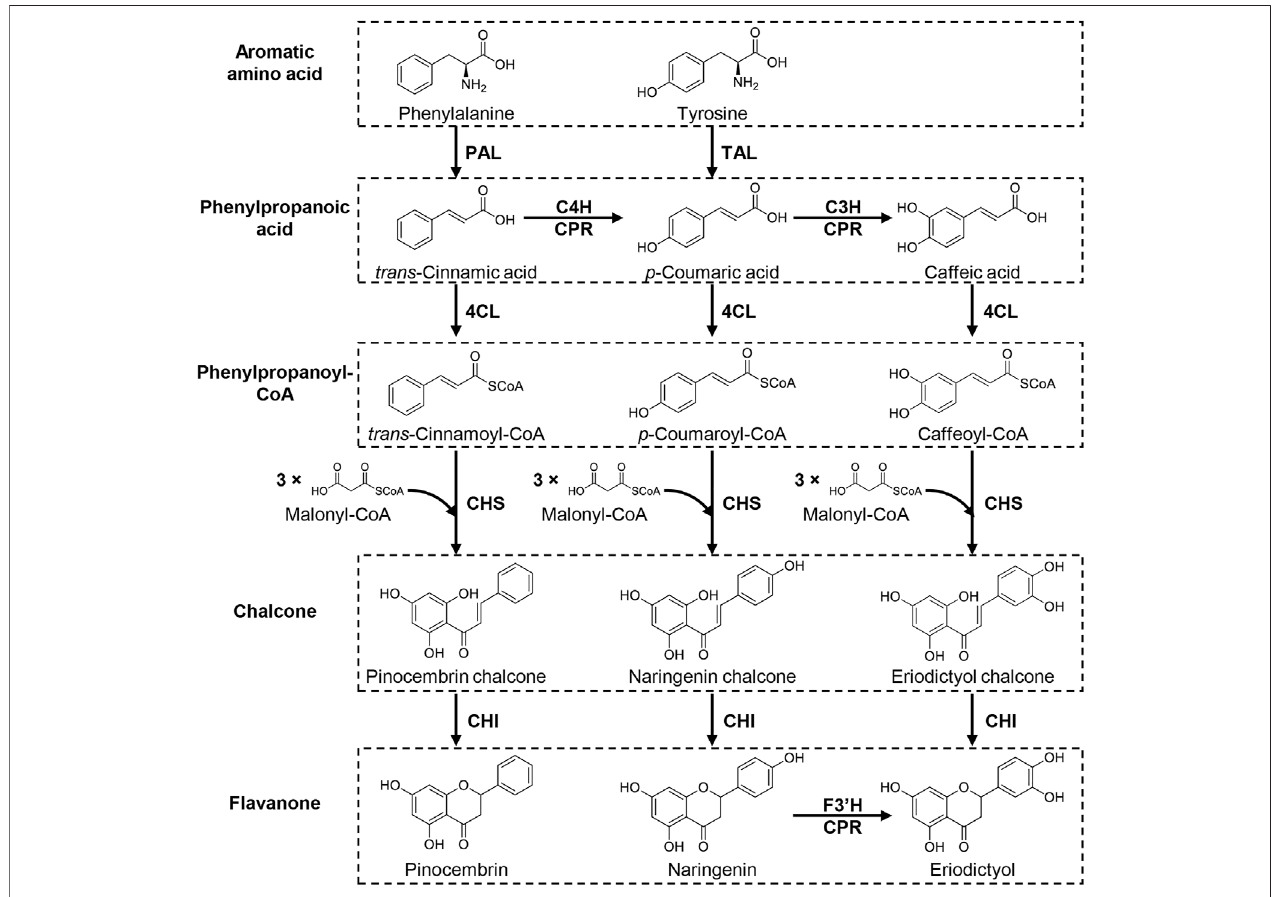
FIGURE 2 | Biosynthetic pathway of fl avanones. Flavanones are synthesized from aromatic amino acids, phenylalanine and tyrosine, via four enzymatic steps: deaminationofaromaticaminoacidtophenylpropanoicacid,ligationofCoAwithphenylpropanoicacidtoyieldphenylpropanoyl-CoA,theClaisen-typecondensationof phenylpropanoyl-CoA with three molecules of malonyl-CoA to form chalcone and isomerization of chalcone to form the C-ring. In this pathway, p -coumaric acid is produced from phenylalanine by a combination of deamination-oxygenation by PAL and C4H (CPR) or directly synthesized from tyrosine via TAL-catalyzed deamination. p -Coumaric acid isfurtherhydroxylated byC3H (CPR) toform caffeic acid,aprecursor for eriodictyol. Eriodictyol canbeproduced via hydroxylation ofC3 ′ in theB-ringofnaringeninbyF3 ′ H(CPR).PAL, phenylalanine ammonia lyase;TAL, tyrosine ammonialyase;C4H, tans -cinnamate4-hydroxylase; C3H, p -coumaricacid 3-hydroxylase; CPR, cytochrome P450 reductase; 4CL, 4-coumaroyl-CoA ligase; CHS, chalcone synthase; CHI, chalcone isomerase; F3 ′ H, fl avonoid 3 ′